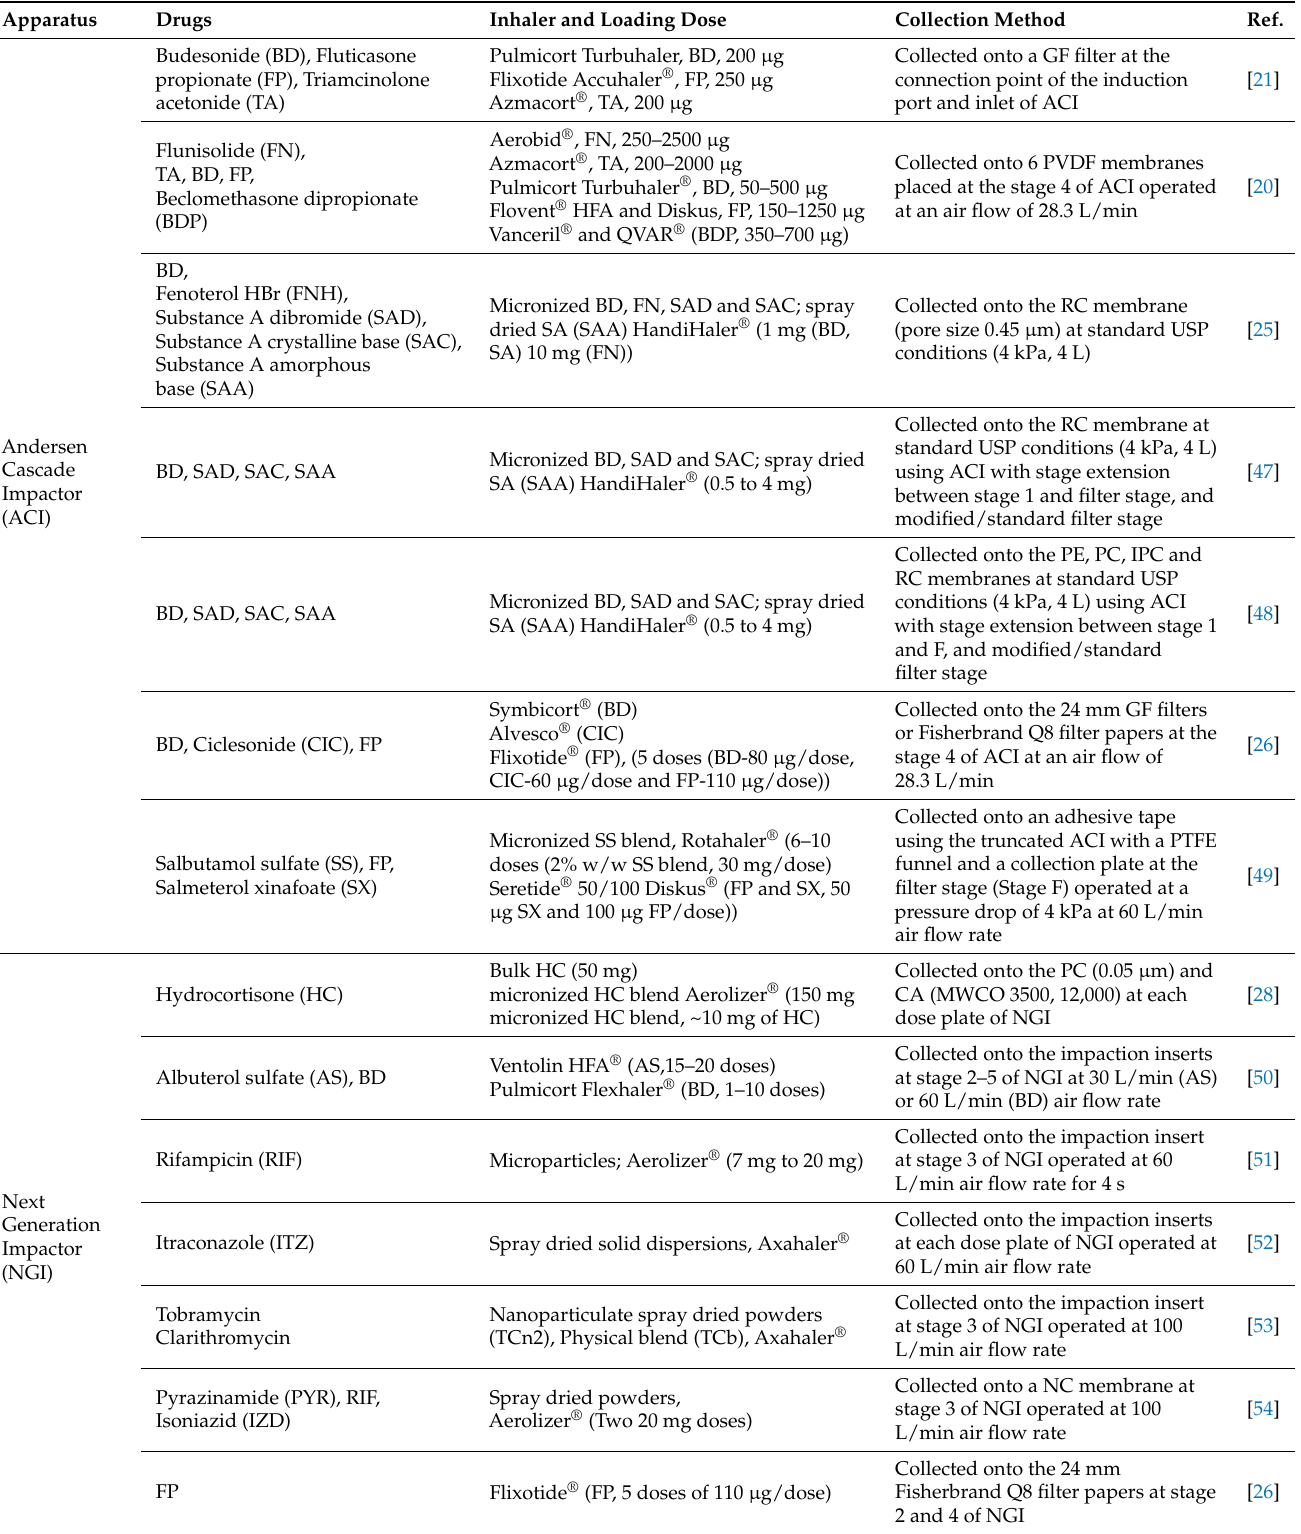
Table 1. Summary of the fine particle dose (FPD) collection methods for dissolution testing of dry powder